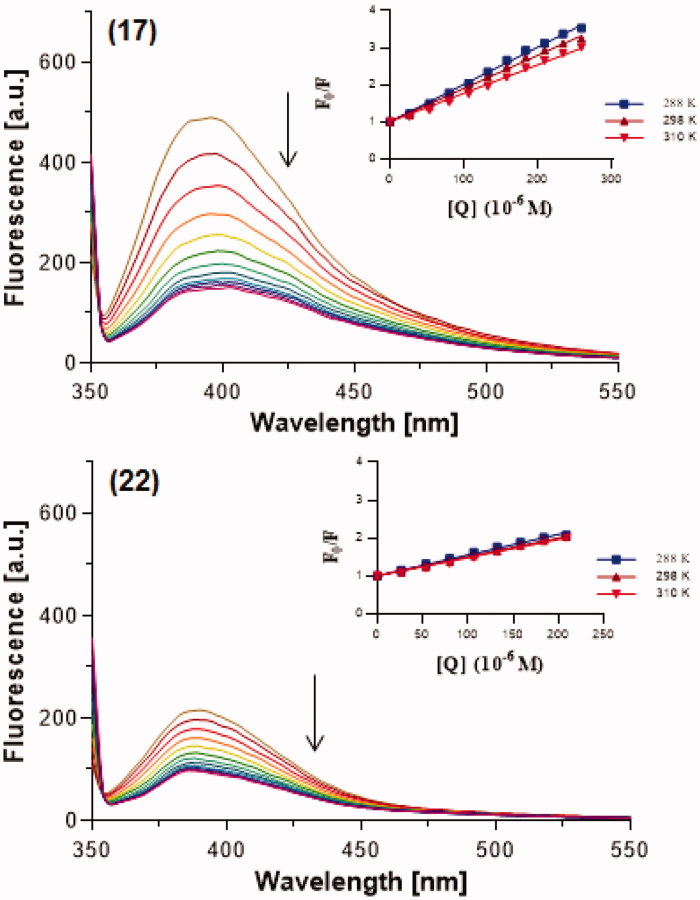
Steady-state fluorescence spectra of studied 7-MEOTA-THA thiourea 17 and urea 22 (5 µM, upper lines) in 10 mM Tris–HCl buffer (pH 7.4) with increasing concentration of ctDNA (0–280 µM, color lines). Arrows show the changes in emission intensity upon increasing ctDNA concentration. The inserted graphs represent the Stern–Volmer plot (plot F0/F versus [Q]) at three different temperatures (288, 298 and 310K).